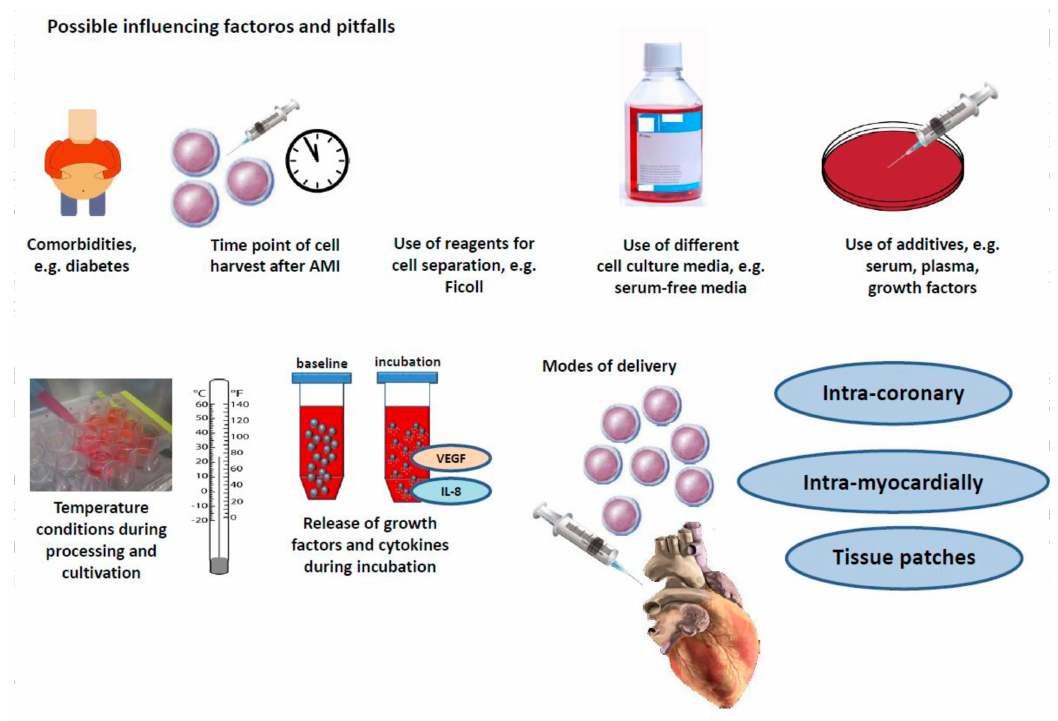
Figure 2. Several mechanisms for paracrine therapy after acute myocardial infarction (AMI) were proposed and